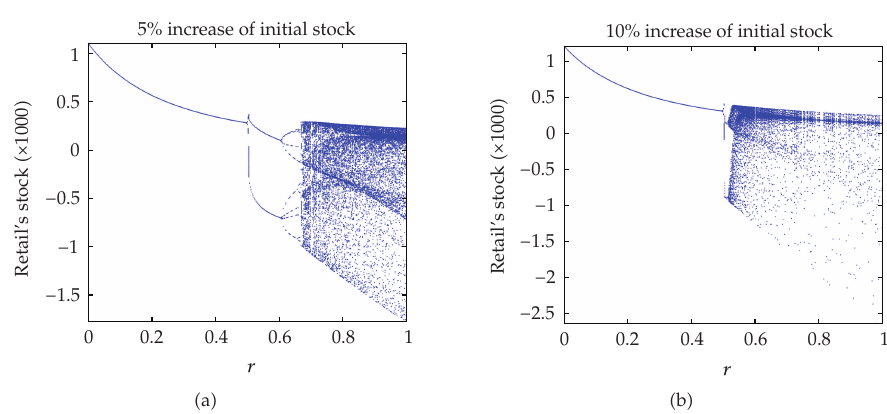
Figure 6: Bifurcation diagram of 5% and 10% increase of initial stock.